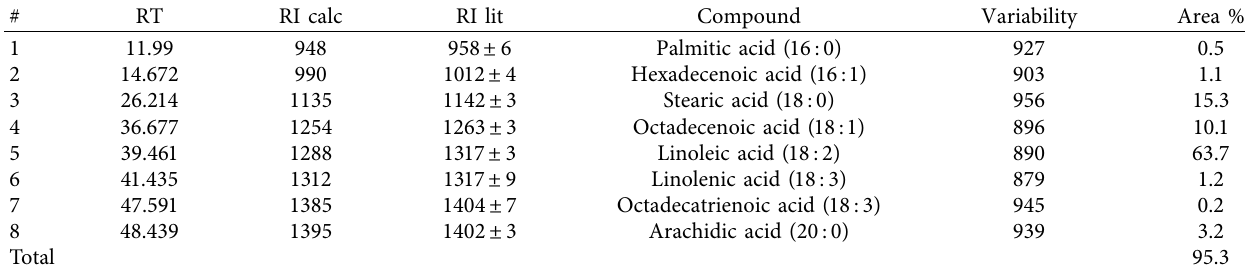
Table 1: Results of chromatographic analysis of the CO